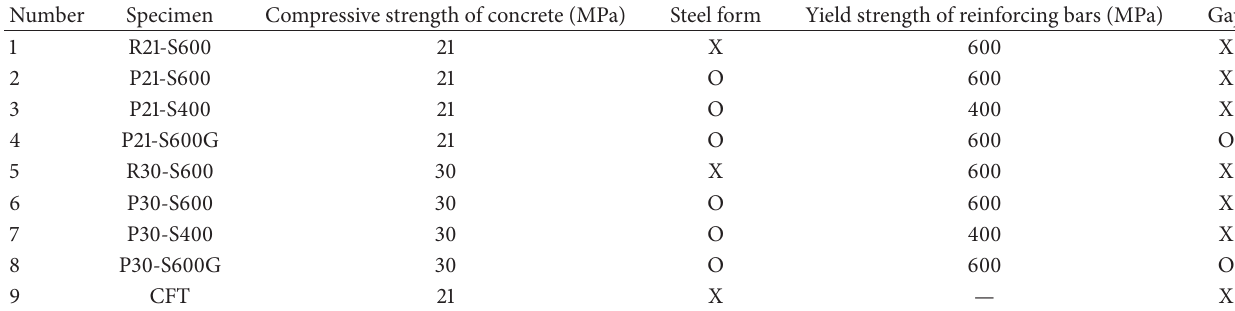
Table 1: Summary of test